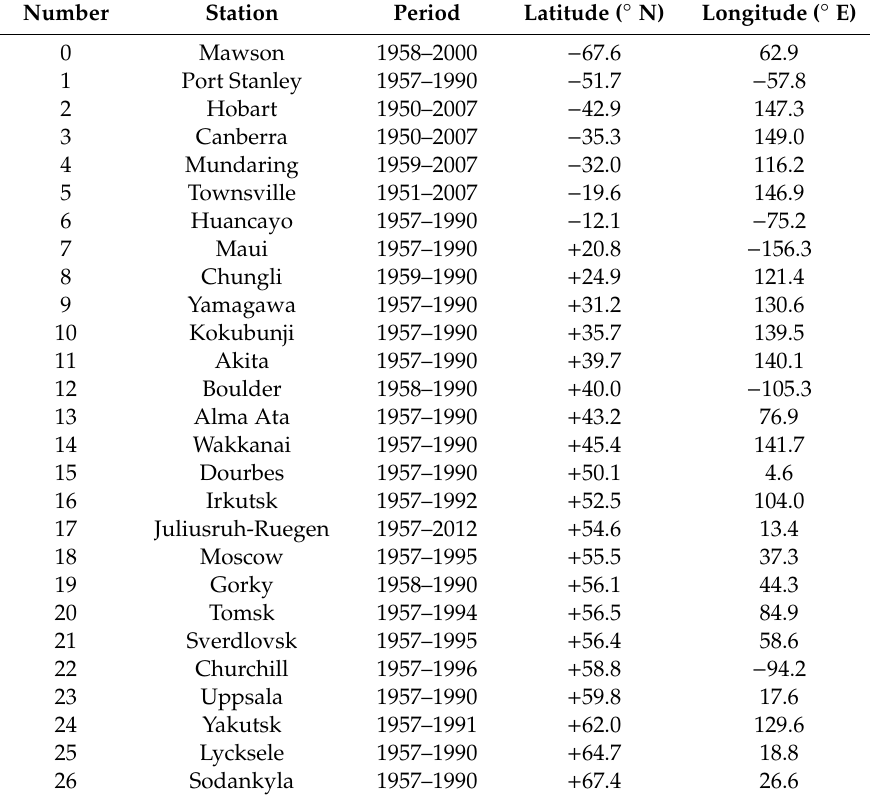
Table 1. List of ionosonde